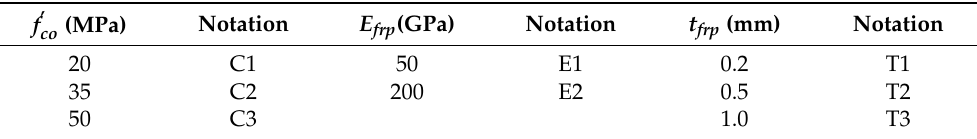
Table 2. Considered values and notations for unconfined concrete compressive strength f (cid:48) co , FRP modulus of elasticity E frp and FRP wrap thickness t frp .